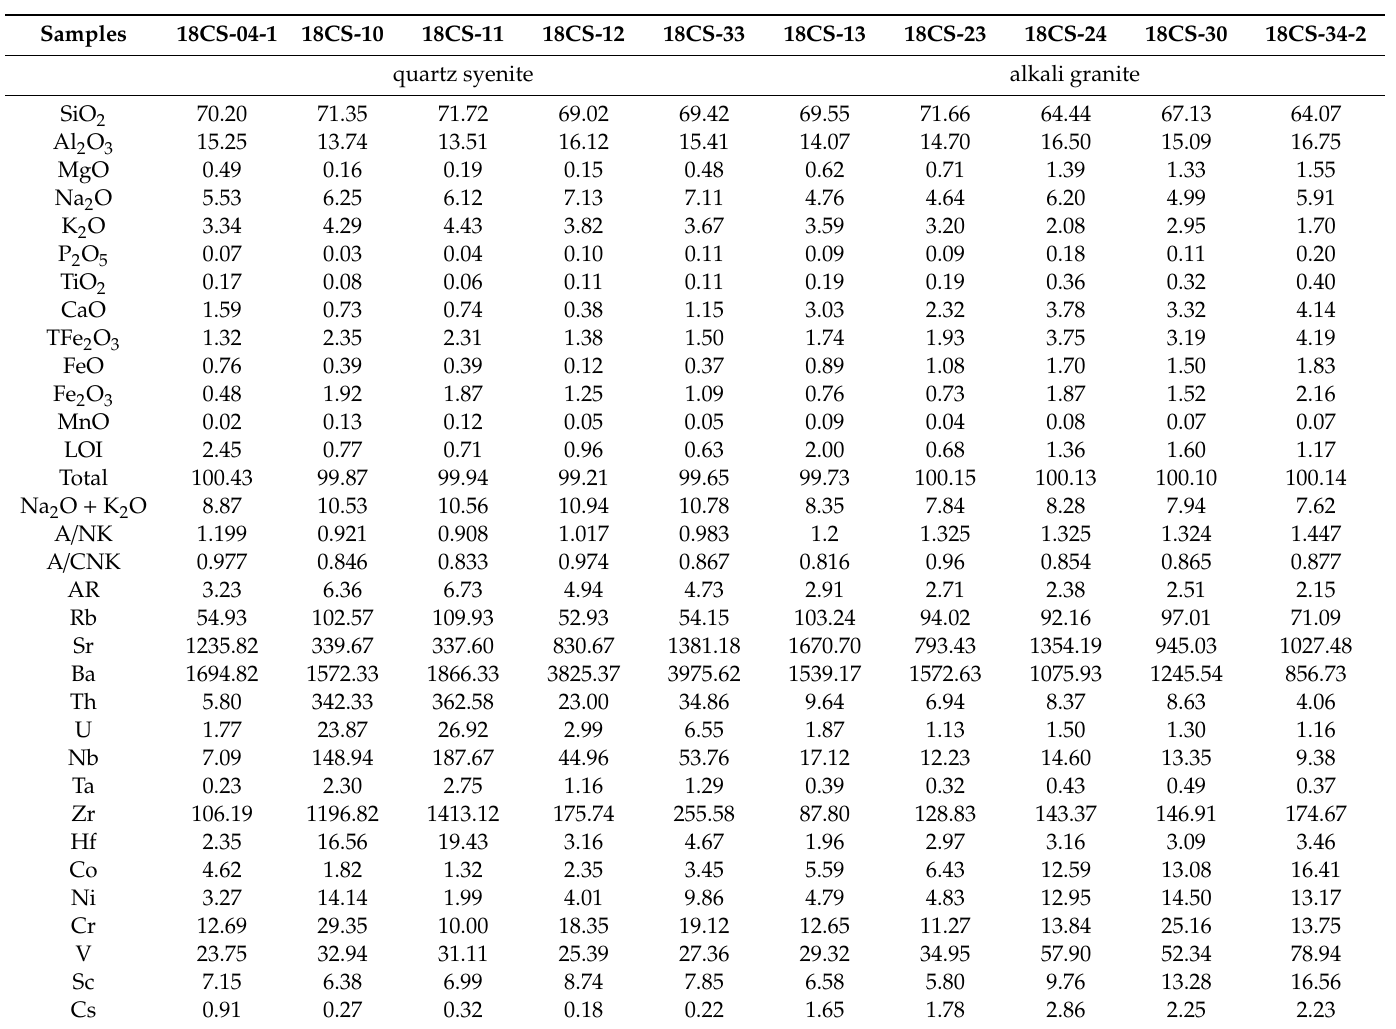
Table 1. Analysis results of the major (wt %) and trace (ppm) elements of the Chishan alkaline complex.